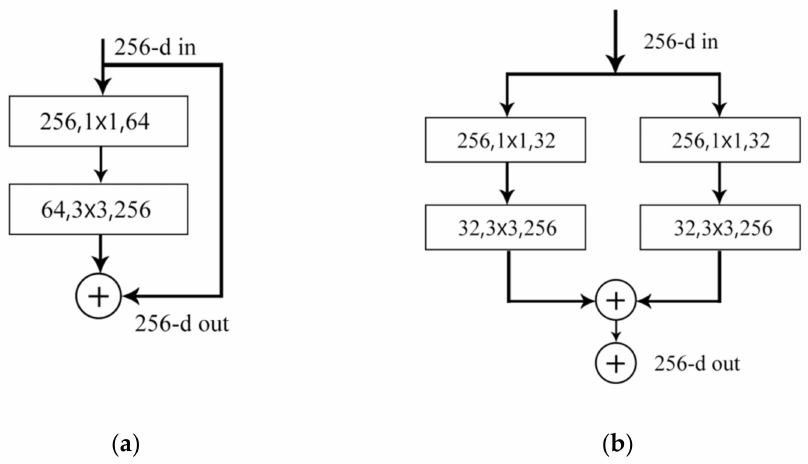
Figure 7. Structure of residual block. ( a ) ResNet block; ( b ) ResNeXt block with cardinality